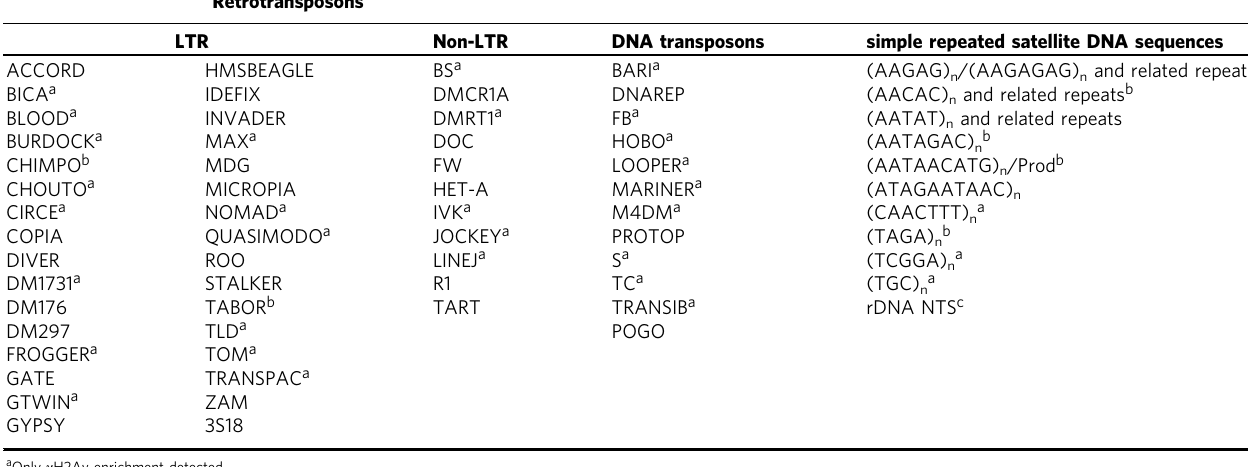
Table 1 Summary of repetitive elements showing speci fi c γ H2Av and R-loops enrichment in dH1-depleted